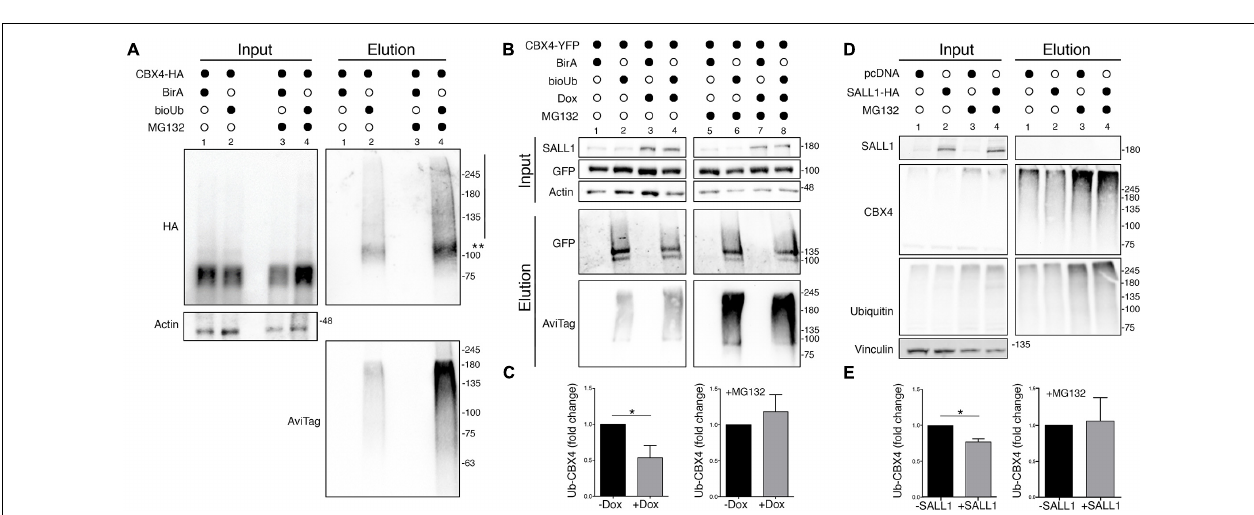
FIGURE 6 | CBX4 ubiquitination is reduced in presence of SALL1. (A) Western blot analysis of HEK 293FT cells transfected with CBX4-HA together with CMV-BirA-2A-bioUb or BirA as a negative control. Cells were treated with 50 µ M of biotin in the presence or absence of 10 µ M MG132. Protein lysates were subjected to pulldown with streptavidin beads and the results were analyzed by Western blot. Two asterisks indicate monoubiquitinated CBX4-HA protein and the vertical line indicates the polyubiquitination smear. (B) Western blot analysis of HEK 293FT_TripZ-SALL1-2xHA cells transiently transfected with CBX4-YFP together with BirA-2A-bioUb or BirA as control. The cells were treated or not with 1 µ g/ml of doxycycline (Dox), in presence or absence of 10 µ M of MG132. Protein lysates were incubated with streptavidin beads to isolate bioUb conjugated proteins and results were analyzed by Western blot. β -Actin was used as loading control. (C) The levels of ubiquitinated CBX4-YFP in Dox induced and not induced cells, in presence (right panel) or absence (left panel) of MG132, were quantified and normalized to the CBX4 levels in the input. (D) Western blot analysis of endogenous CBX4 in HEK 293FT cells transfected with CMV-SALL1-2xHA (lanes 2 and 4) or with pcDNA3 control plasmid (lanes 1 and 3), in presence (lanes 3 and 4) or absence (lanes 1 and 2) of 10 µ M MG132. (E) Quantification of ubiquitinated CBX4 in the elution panel normalized to the CBX4 levels in the input, in cells expressing or not SALL1-HA, in presence (right panel) or absence (left panel) of MG132. (A,B,D) Molecular weight markers are shown to the right in KDa. Antibodies were used as indicated to the left. (C,E) Graphs represent mean plus SEM. P -values were calculated on n = 4 using Mann–Whitney test. * P -value < 0.05.